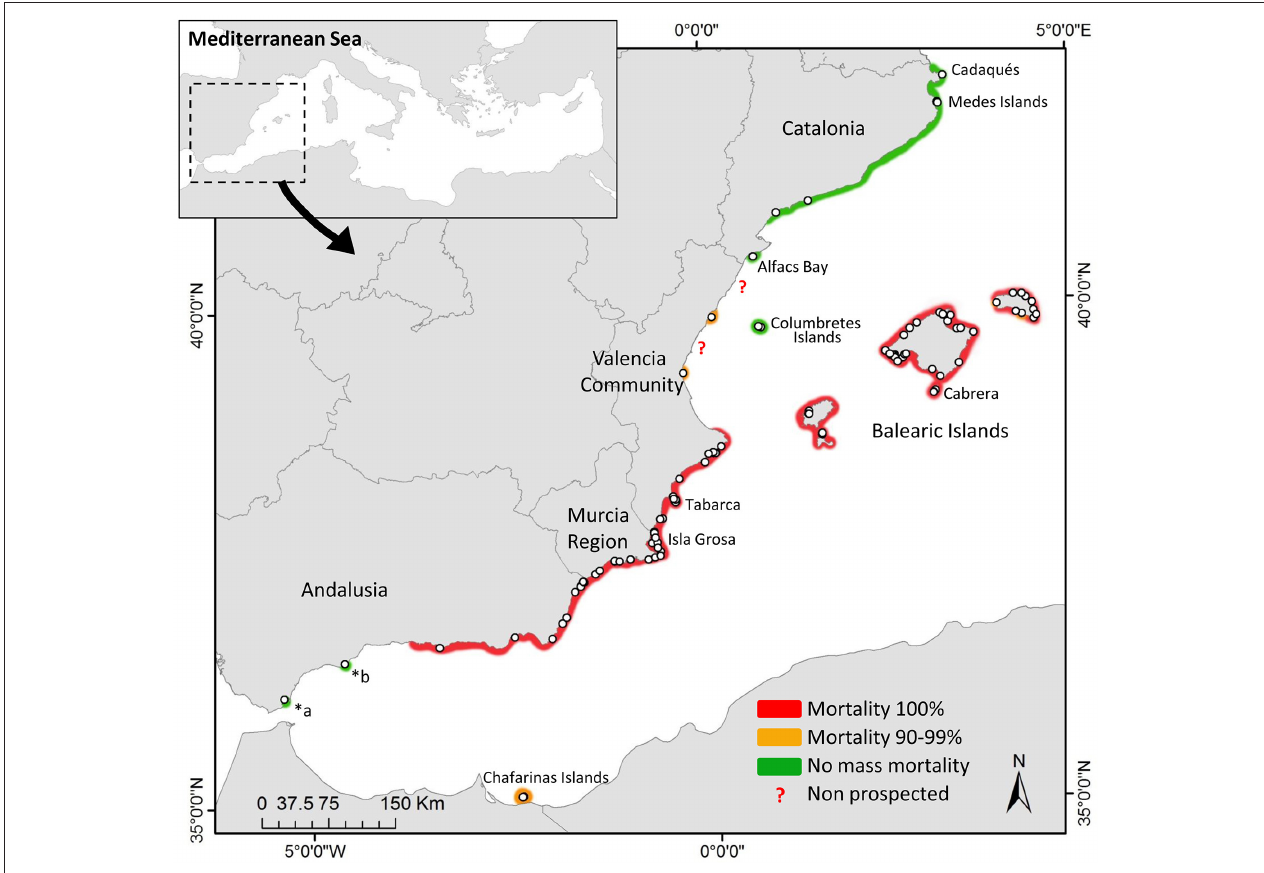
FIGURE 1 | Extent of the mass mortality event on Pinna nobilis in western Mediterranean Sea. White dots indicate the sampling localities from September 2016 to June 2017, red shading, mortality of 100% of individuals censed; shaded orange, mortality between 90 and 99% of individuals censed; and green shading, no mass mortality detected. Question marks are places where there are P. nobilis populations but it has not been possible to carry out censuses to evaluate the state of the populations in the frame of the MME. *Individuals isolated due to being at their distribution limit: a Only four living specimens in Algeciras Bay; and b One living